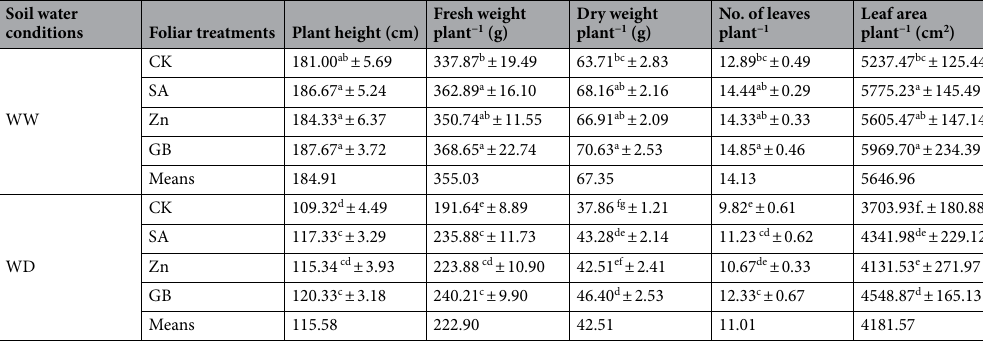
Table 1. Effect of soil water conditions and foliar treatments on plant height, fresh weight, dry weight, number of leaves, and leaf area. Values are means (± SE) of three replicates. For L.S.D.’s results, means with different letters indicate that means are different at 95% confidence level. WW, well-watered; WD, water-deficient; CK, control (double distilled water); SA, salicylic acid; Zn, Zinc; GB, Glycine